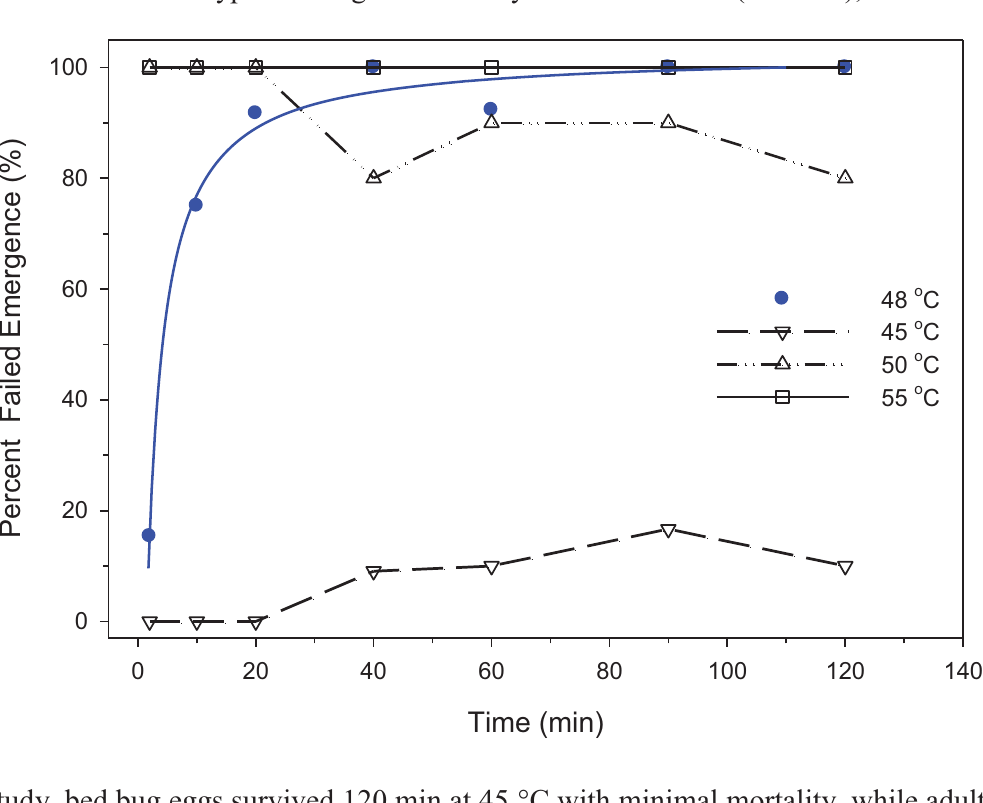
Figure 3. Threshold temperature for bed bug eggs that failed to emerge ( (cid:2) ; Hyperbola regression ── ) within 2 h of attaining a target temperature of 48 °C. The other three lines indicate the mortality response of eggs above and below this threshold temperature.